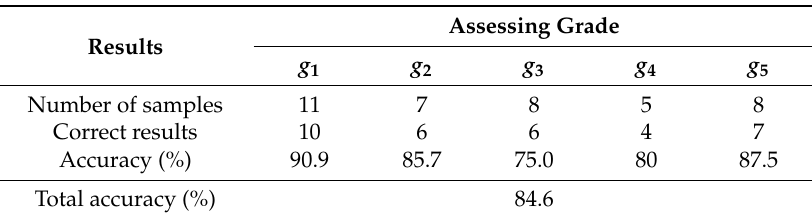
Table 7. Assessing result of